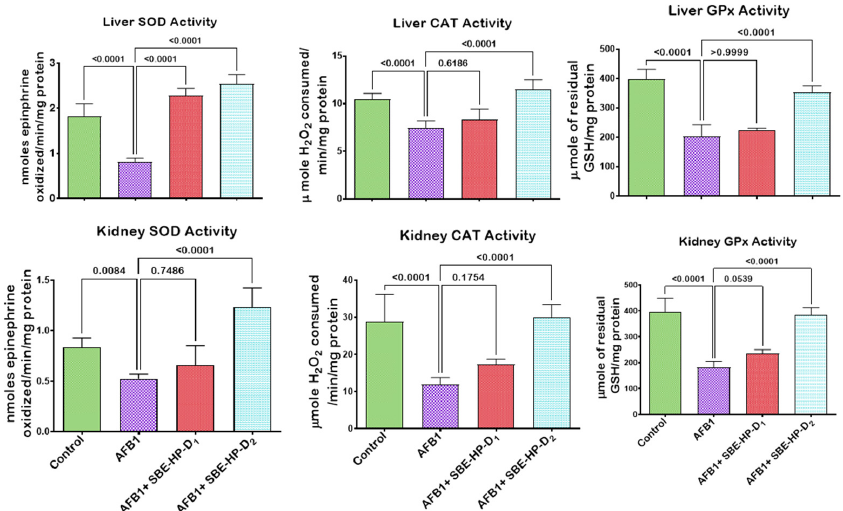
Figure 5. Effect of SBE-HP on the tissue concentrations of CAT, SOD, and GPx in the liver and kidney of rats treated with AFB 1 for 28 d. AFB 1 at 50µg/kg; SBE-HP-D1 at 5 mg/kg; SBE-HP-D2 at 10 mg/kg. Values are expressed as mean ± SD for six rats per treatment cohort. Connecting lines indicate groups compared to one another. The significance level was set at ( p < 0.05); p < 0.05 indicates the level of significance; p > 0.05: not significant. AFB 1 : Aflatoxin B1; D1: lower dose; D2: higher dose; SOD: Superoxide dismutase; CAT: Catalase; GPx: Glutathione